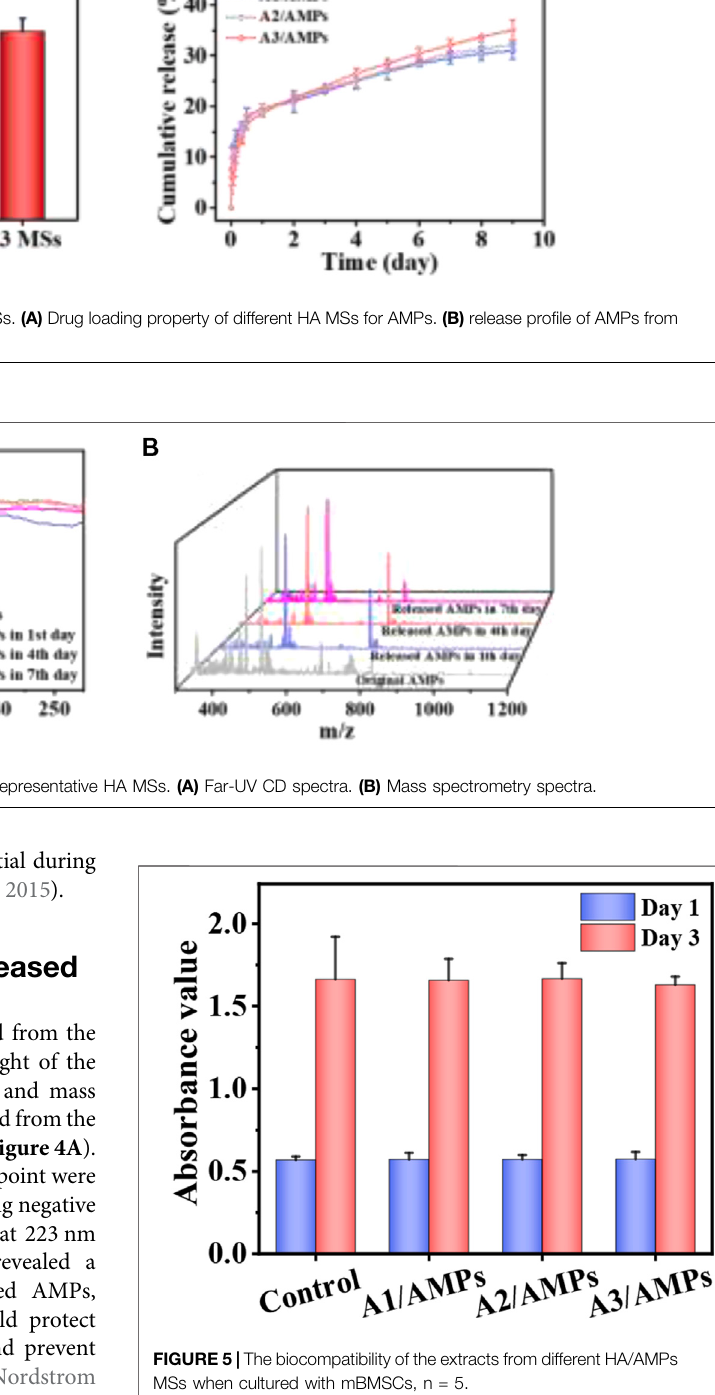
Frontiers in Chemistry |